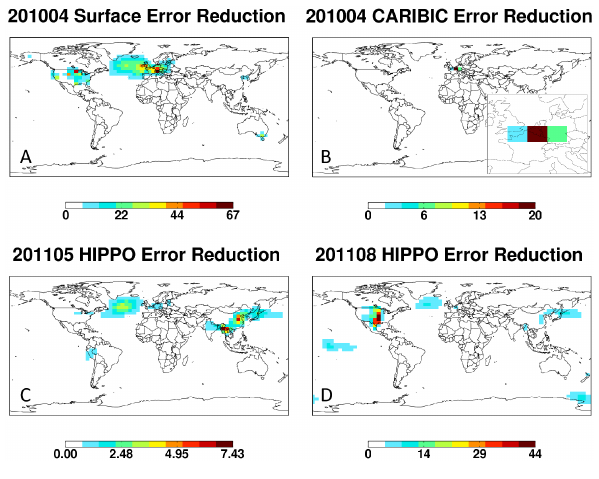
Figure 9. Error reduction (%) in N 2 O emissions achievable in se- lected months using surface (a) , CARIBIC (b) , and HIPPO (c and d) measurements. An inset shows regional detail for the CARIBIC results. The relative error reduction is calculated based on a stochas- tic estimate of the inverse Hessian of the cost function for the inver- sion, and represents the ability of the observing system to remove a random emission error for each given location in the absence of any large-scale source bias.